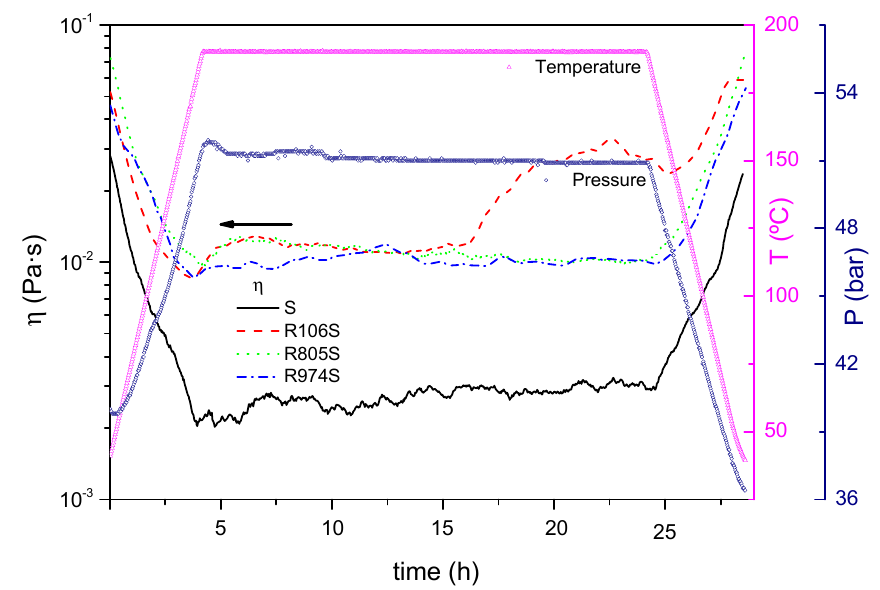
Figure 5. Evolution of viscosity with aging time for the HFS suspensions studied.